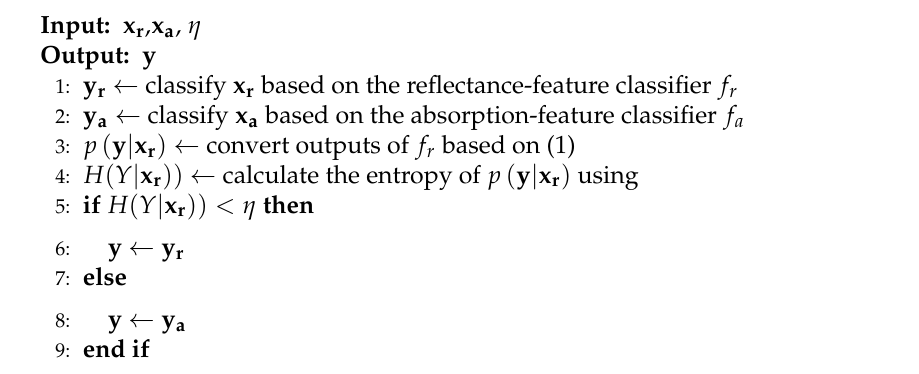
Algorithm 3: An entropy mediated decision level